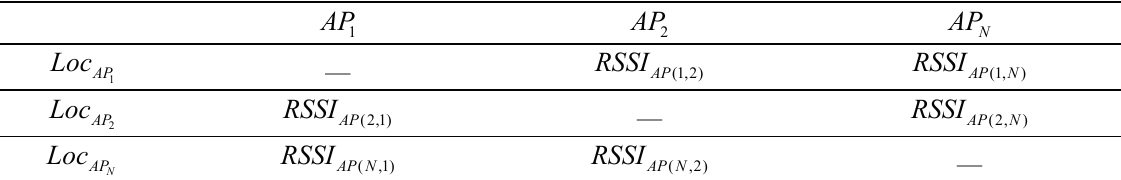
Table 1. Online RSSI Observation between APs.